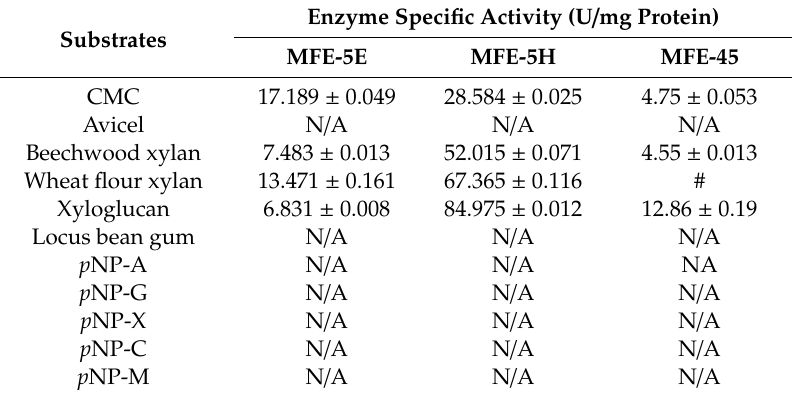
Table 2. Substrate specificity of enzymes on polymeric and p -nitrophenyl substrates.